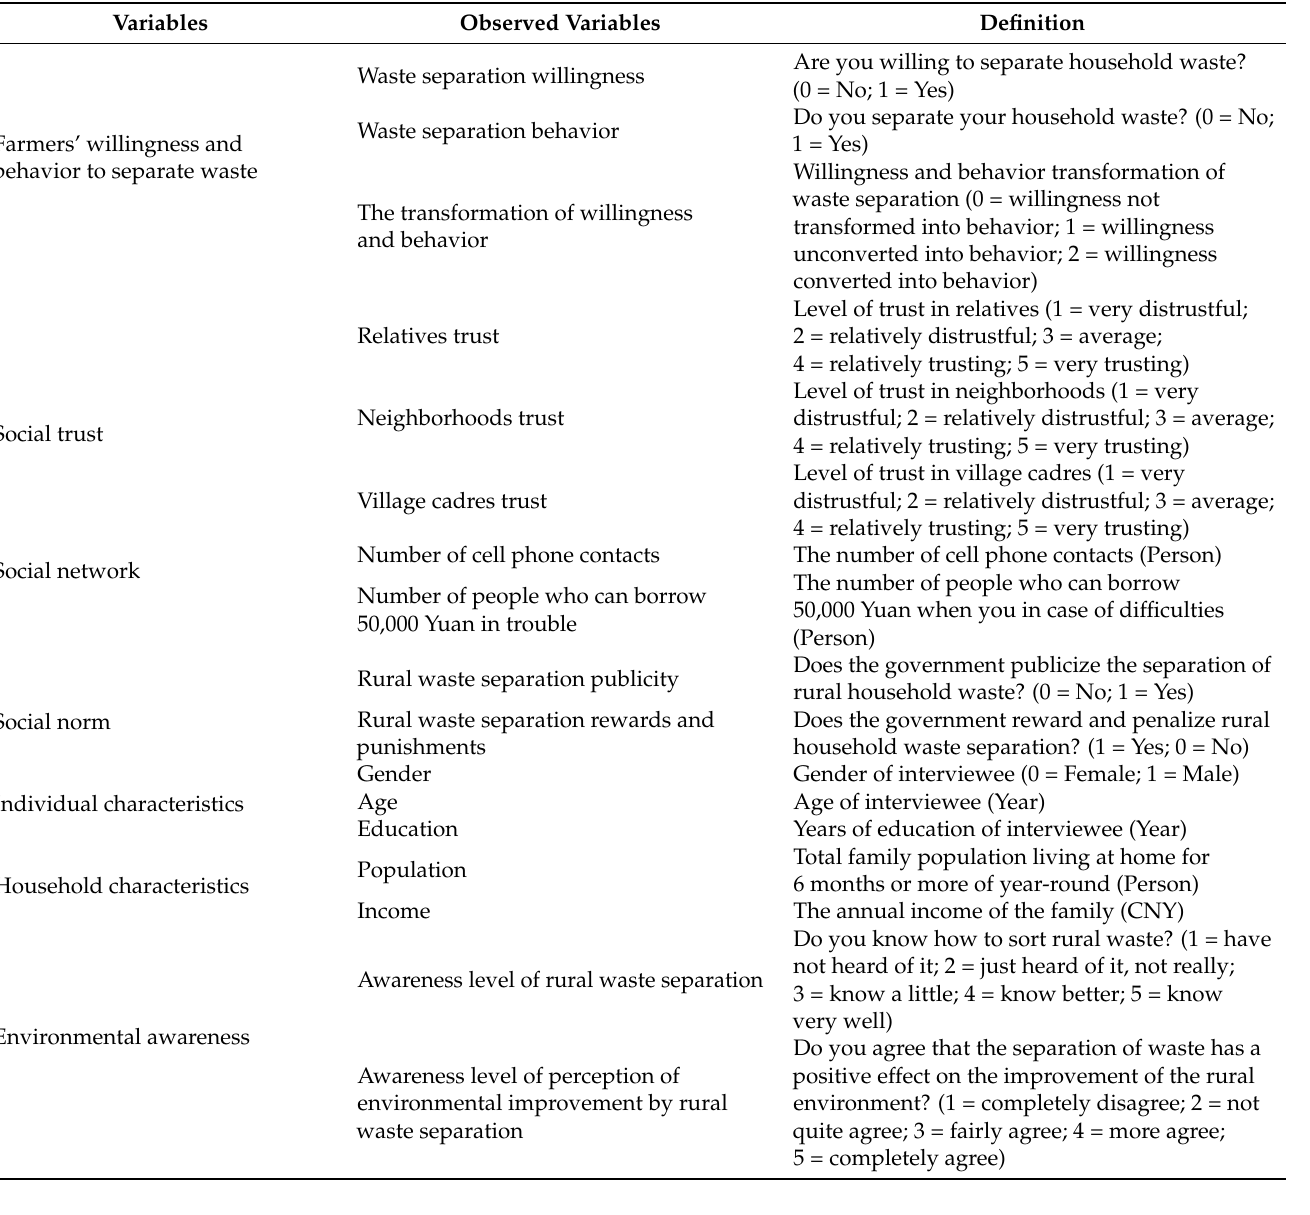
Table 1. Variable definition and descriptive